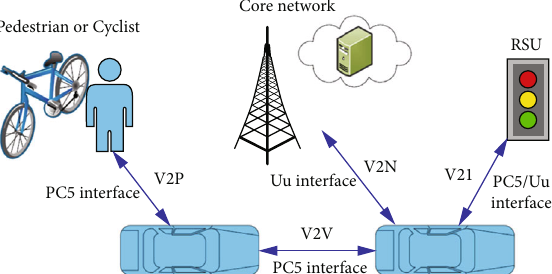
Figure 2: Schematic diagram of vehicle networking communication types and their basic fl ow